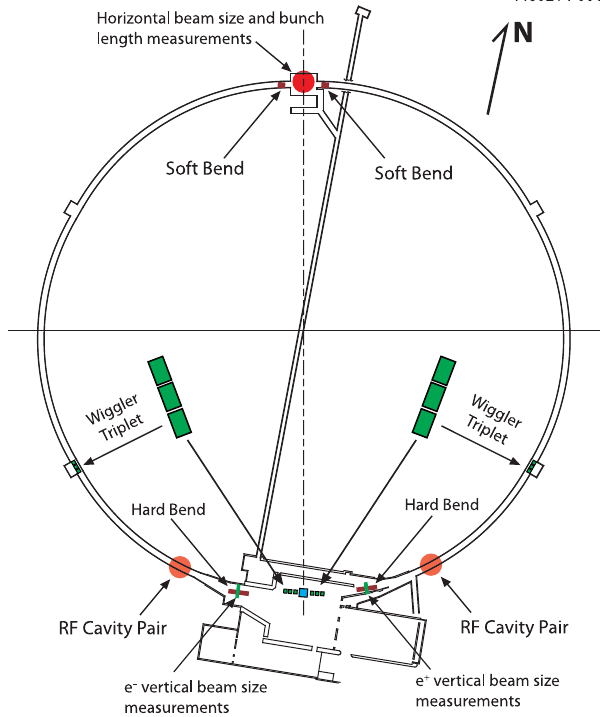
FIG. 1. The configuration of the Cornell Electron Storage Ring Test Accelerator